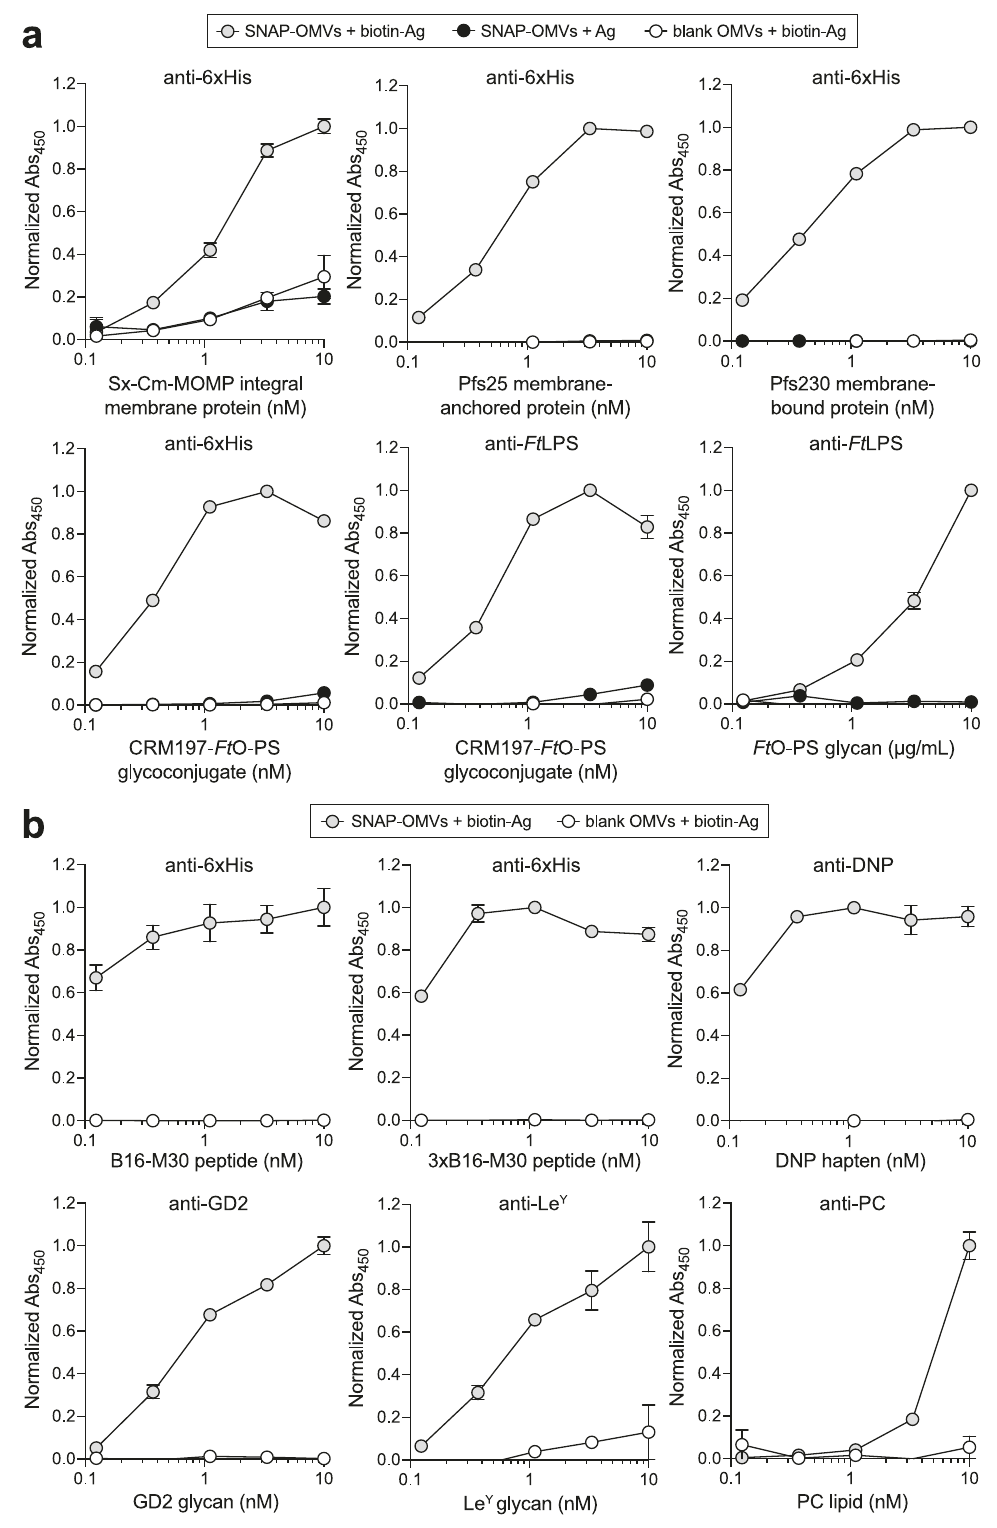
Fig. 3 | Assembly of OMV vaccine candidates decorated with diverse biomole- cular antigens. a , b Dose – response curves generated by loading biotinylated or unbiotinylated antigens on SNAP-OMVs isolated from hypervesiculating KPM404 Δ nlpI cells expressing the Lpp-OmpA-eMA construct from plasmid pTrham (induced with 0.5 mM L-rhamnose). Blank OMVs were isolated from plasmid-free KPM404 Δ nlpI cells.BindingactivitywasdeterminedbyELISAinwhichLpp-OmpA-